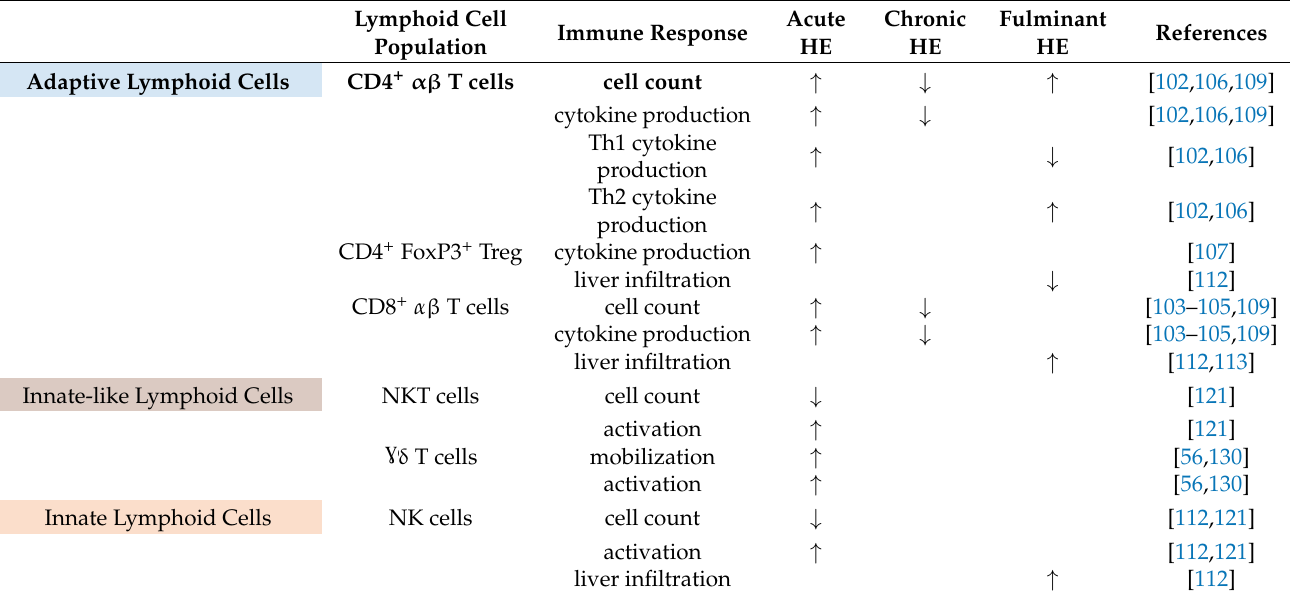
Table 1. Immune response by lymphoid cells due to HEV